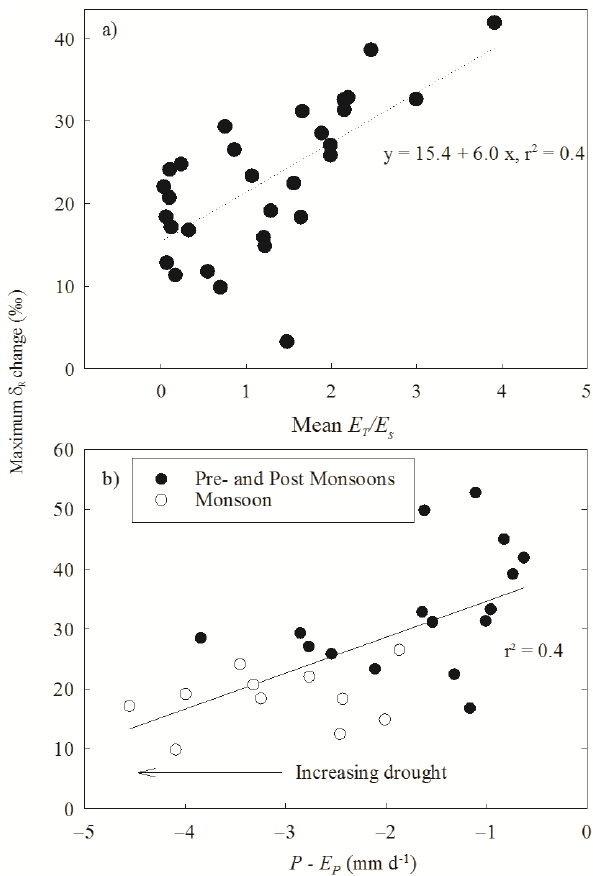
Fig. 8. (a) The relationship between maximum δ R change within 7–11 days after each pulse and mean E T / E S change for the same pe- riods. The regression equation is δ R = 15.4 + 6.0 E T / E S , r 2 = 0 . 4. (b) Relationships between maximum δ R change and the drought index P − E P . Each data point represents the combination of maxi- mum δ R change and mean P − E P over the same period, with each subset starting on the day of the rain pulse and extending to the day before the next rain